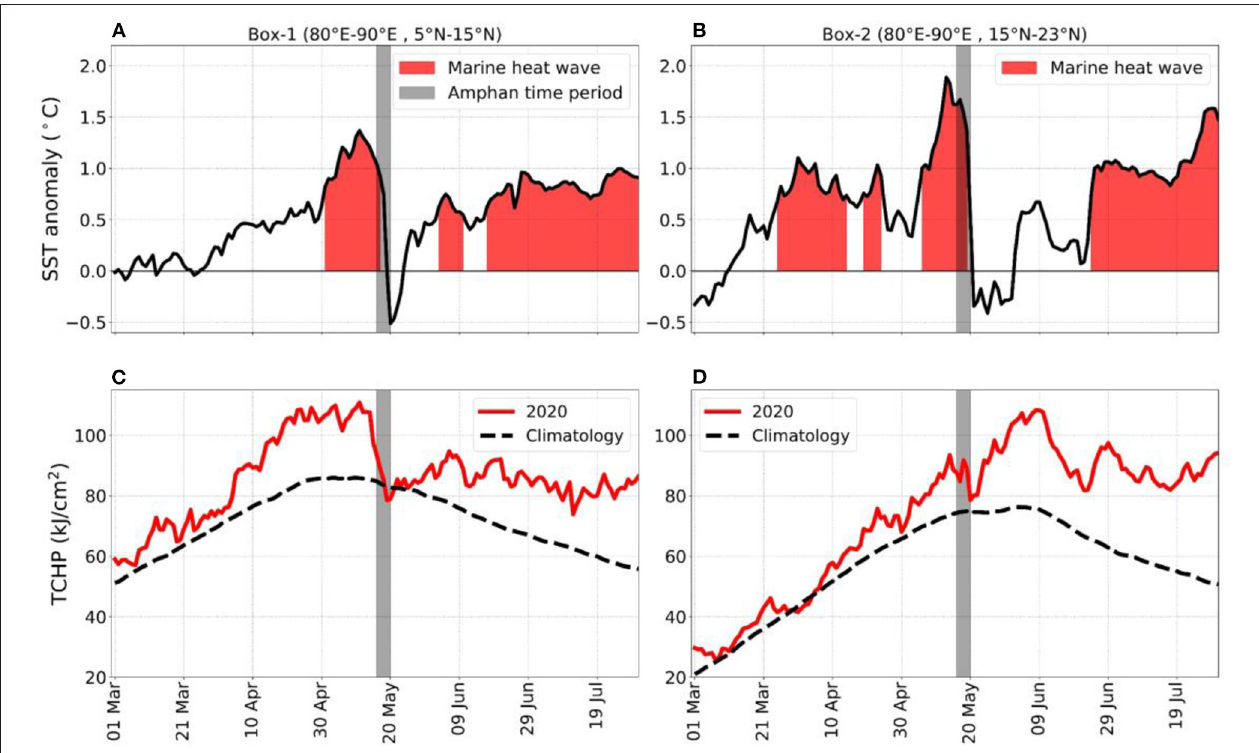
FIGURE 7 | (A,B) Time series of sea surface temperature anomaly (black, ◦ C), (C,D) tropical cyclone heat potential (red, kJ cm − 2 ) for box 1 (left column) and box 2 (right column), for the duration of 26-April-2020 to 31-July-2020 with the red shading representing marine heatwave conditions, daily climatology for (C) sea surface temperature and (D) tropical cyclone heat potential (black), and vertical gray shading representing the duration of tropical cyclone